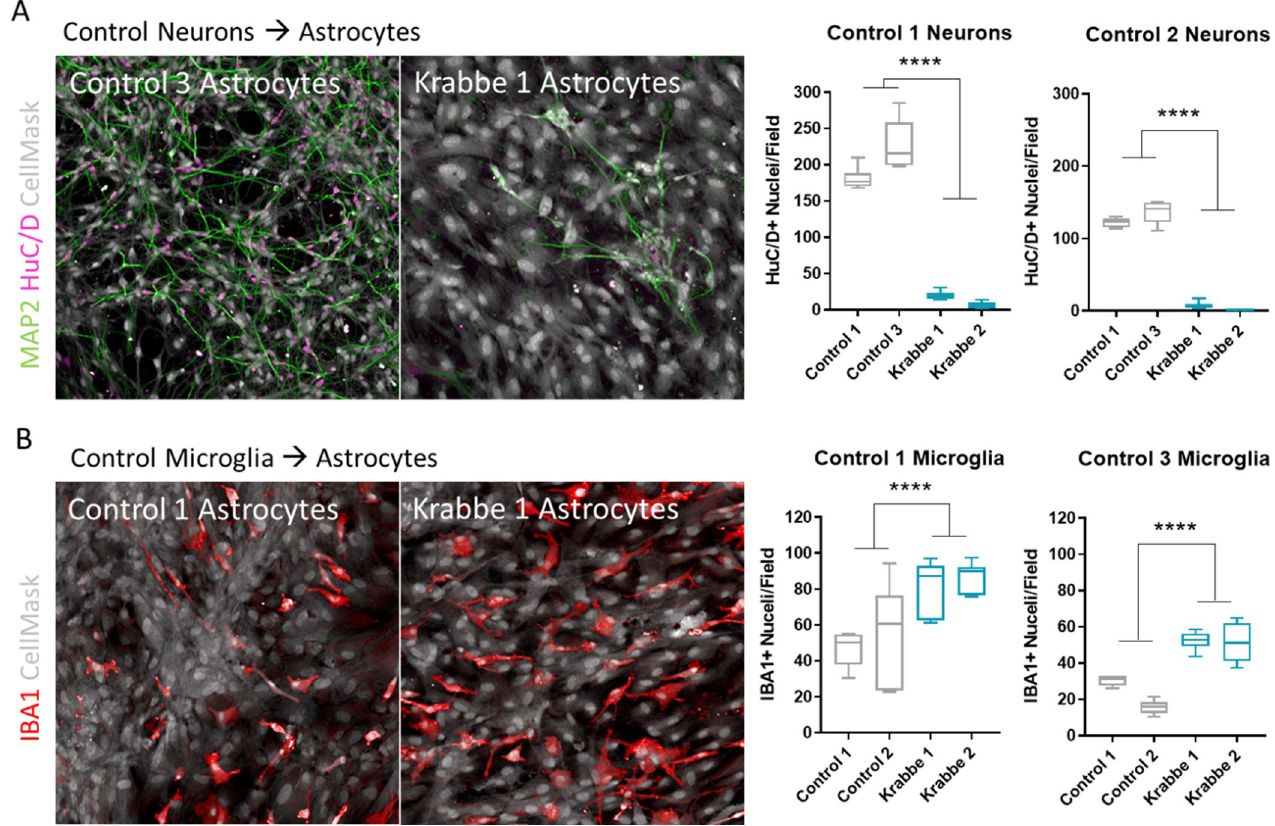
Fig 4. Krabbe astrocytes impact survival of iPSC-derived neurons and microglia in co-culture. Cryopreserved astrocytes from healthy control or Krabbe donors were thawed and cultured for 7 days. Neurons or microglia-like cells generated from two control donors were then seeded onto the established control or Krabbe astrocytes. (A) Representative images of HuC/D positive (purple) and MAP2 positive (green) neurons following 96-hour co-culture with control or Krabbe astrocytes. Significantly fewer HuC/D+ neurons were identified when co-cultured with Krabbe astrocytes. (B) Representative images of IBA1+ (red) microglia following 96-hour co-culture with control or Krabbe astrocytes. A significantly greater number of IBA1+ microglia were identified when co-cultured with Krabbe astrocytes. Representative images in panels A and B were acquired at 20x magnification. ���� p < 0.0001. Data for individual donor subjects is shown as a box and whisker plot with median represented and errors bars indicating min/max values. Statistical analysis was conducted using t-tests on pooled data comparing control vs. Krabbe cells.